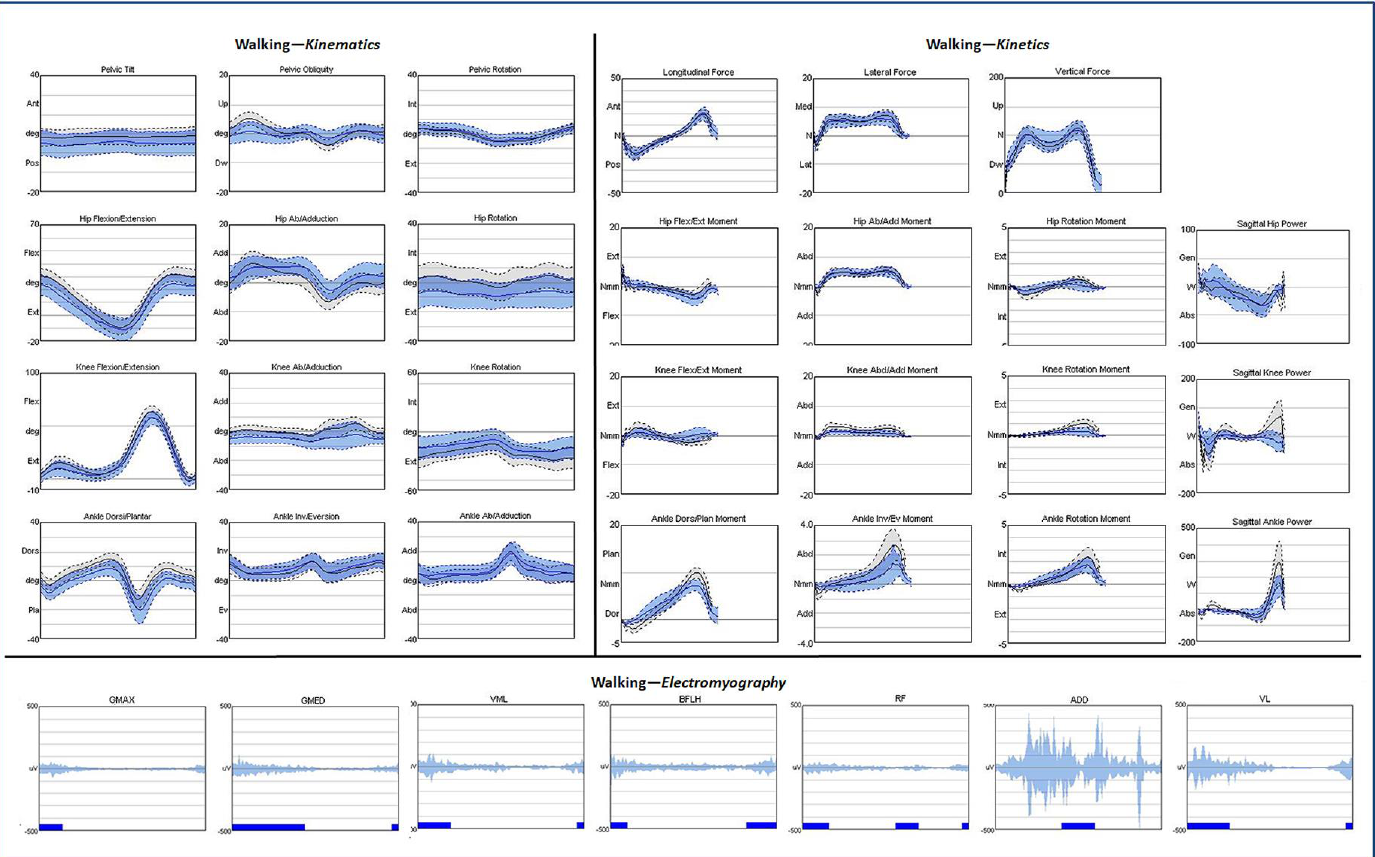
Figure 3. The time-history of the main gait variables from the GA during level walking. Joint rotations (left) and moments (right) from these patients (blue) are reported as the mean plus one standard deviation bands for all patients superimposed onto the corresponding bands from the control population. Electromyographic signals from the muscle activation are also reported for a single typical patient (bottom) along with the corresponding physiological timing on the horizontal axis: gluteus maximus (GMAX), gluteus medialis (GMED), rectus femoris (RF), great adductor (ADD), vastus medialis (VML), vastus lateralis (VL), and long head of the biceps femoris (BFLH).